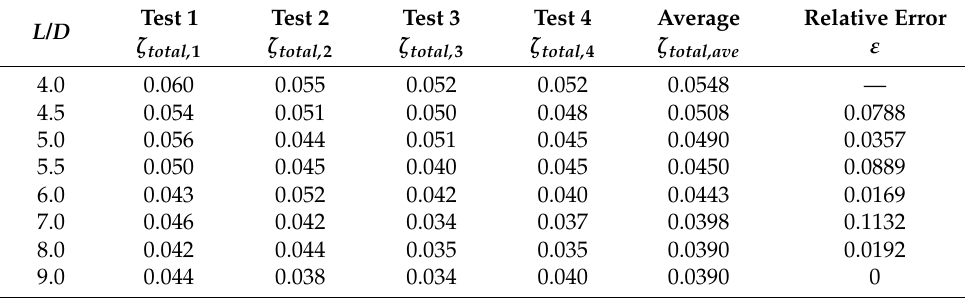
Table 5. Free decay test results of ζ total at various spacing